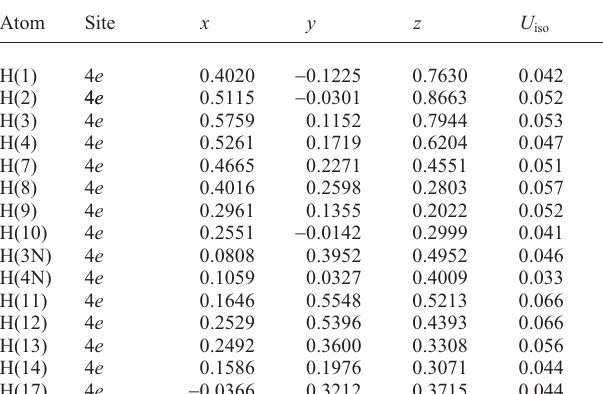
Table 2. Atomic coordinates and displacement parameters (in Å 2 ) .